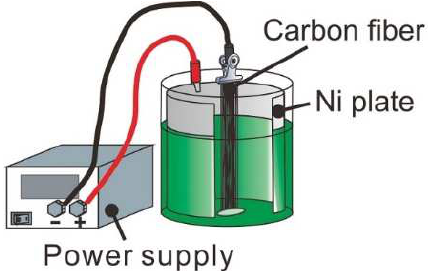
Figure 1. Schematic drawing of electrolytically plating Ni method.